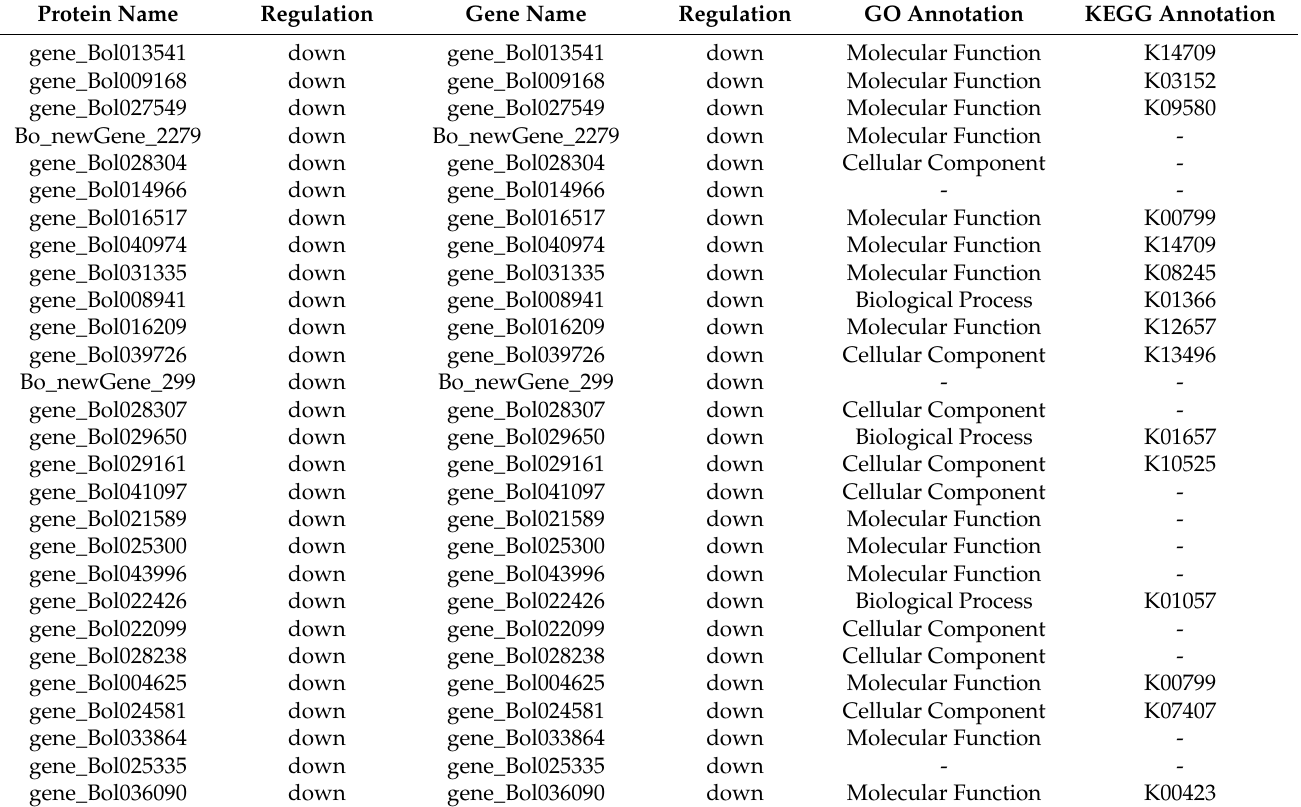
Figure 5. Nine-quadrant diagram of protein and transcriptome expression patterns in different groups. Quadrants 1 and 9 indicate opposite trends of protein and mRNA expression; Quadrant 3 and 7 show the same trend of protein and mRNA expression. Quadrants 2 and 8 indicate no change in protein, but differentially expressed mRNA. Quadrants 4 and 6 indicate no change in differential mRNA and protein expression. Table 3. Common differentially expressed genes between the proteome and the